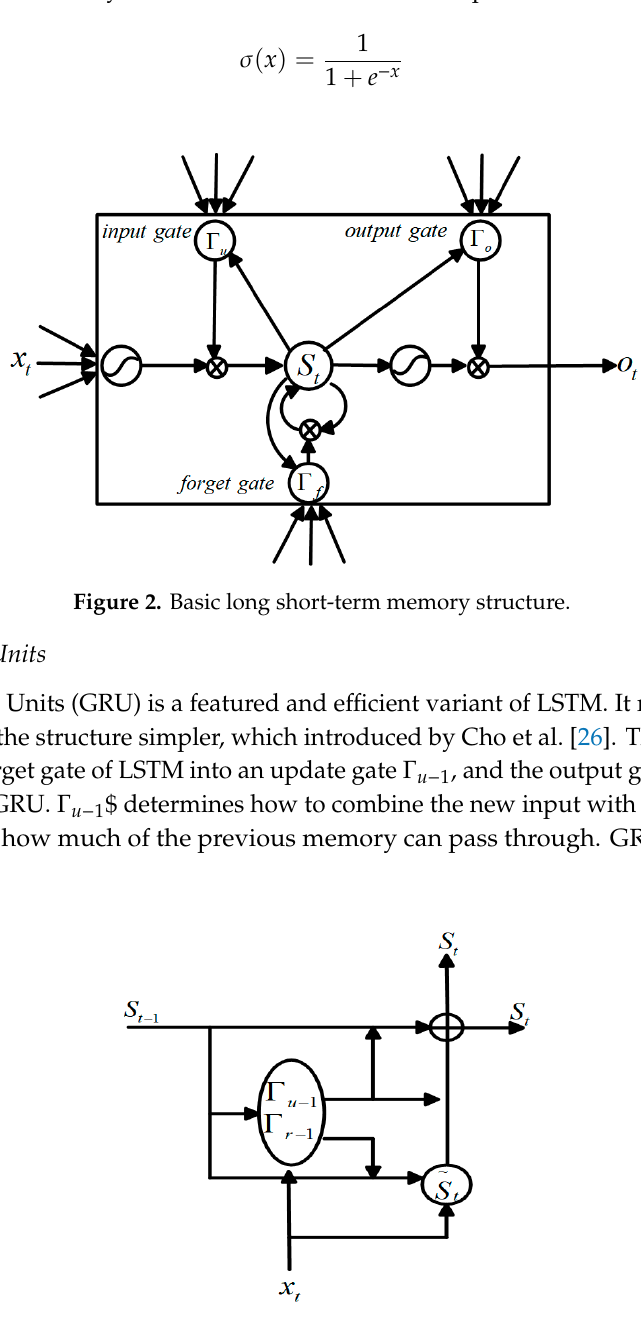
Figure 3. Basic gated recurrent units structure.